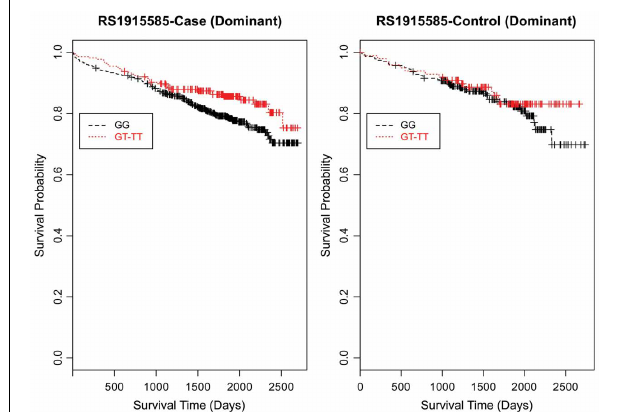
FIGURE 6 | Kaplan–Meier survival curves for CAD cases vs. controls in dominant (allele) model for LSAMP SNP rs6788787. X -axis displays the number of days from catheterization to death (all-cause mortality). Y -axis displays the Kaplan-Meier survival probability by genotype. A is the minor allele; GG, wild-type genotype (reference; black curve); and red curve indicates GA and AA genotypes combined.